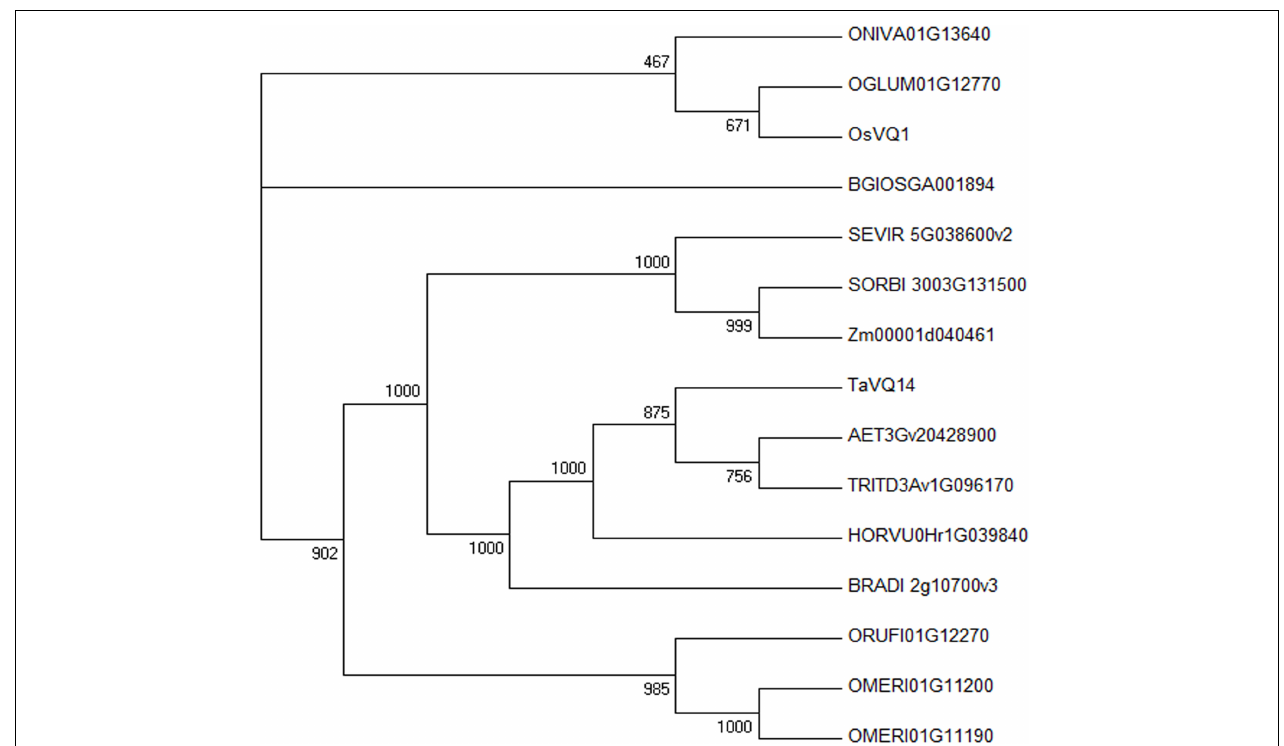
FIGURE 1 | Phylogenetic analysis of TaVQ14 and its homologs. Homologs : Aegilops tauschii, AET3Gv20428900; Brachypodium distachyon, BRADI_2g10700v3; Hordeum vulgare, HORVU0Hr1G039840; Oryza glumipatula, OGLUM01G12770; Oryza sativa Indica Group, BGIOSGA001894; Oryza meridionalis, OMERI01G11190; Oryza meridionalis, OMERI01G11200; Oryza nivara, ONIVA01G13640; Oryza rufipogon, ORUFI01G12270; Oryza sativa Japonica Group, OsVQ1 (Os01g0278000); Setaria viridis, SEVIR_5G038600v2; Sorghum bicolor, SORBI_3003G131500; Triticum turgidum, TRITD3Av1G096170; Zea mays,